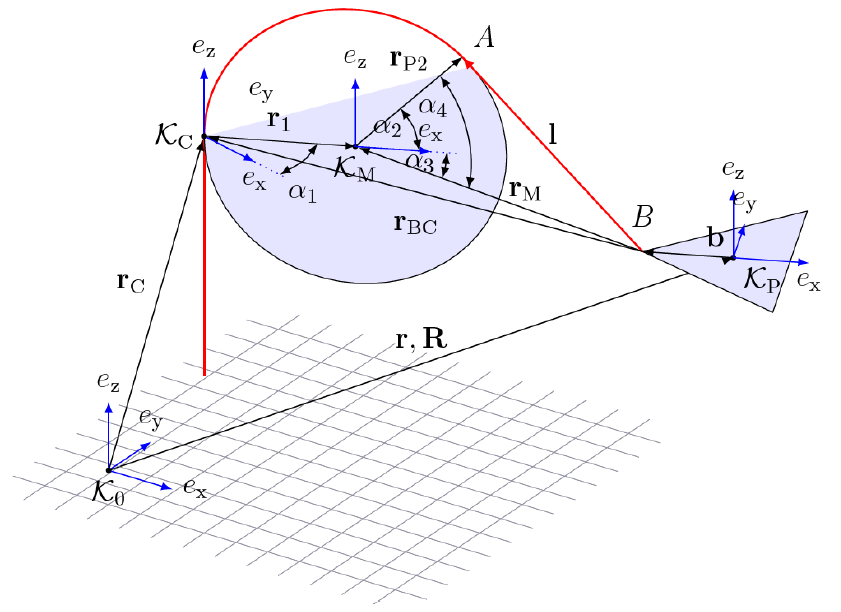
Figure 6. Kinematic loop of i -th cable taking into account a pulley with non-negligible